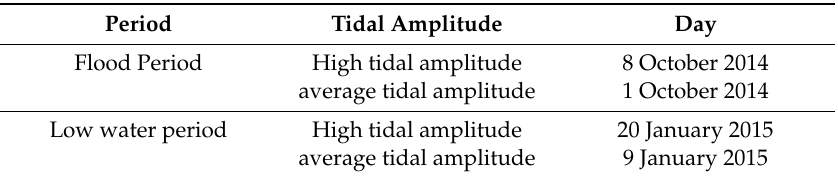
Table 2. The periods considered for simulation analysis.